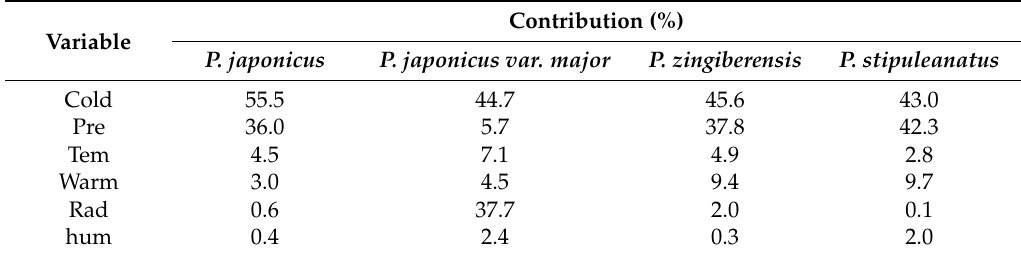
Table 3. Contribution of ecological factors (%) based on MaxEnt.